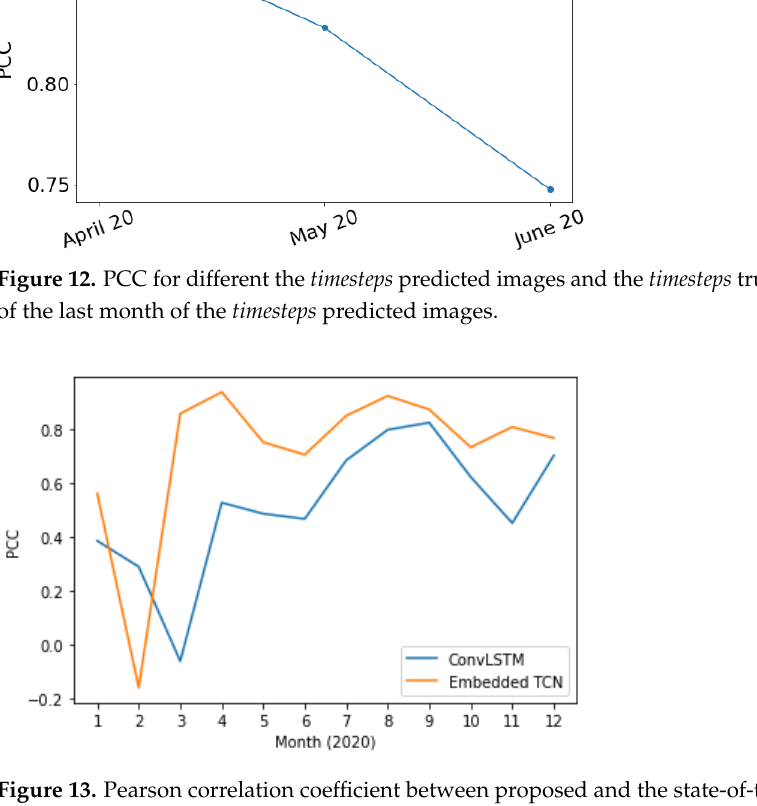
Figure 13. Pearson correlation coefficient between proposed and the state-of-the-art method for LST prediction over different months of 2020.